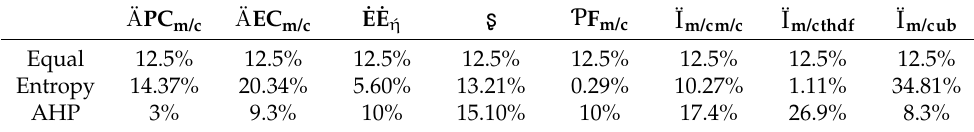
Table 16. Weights of energy responses computed using three methods.